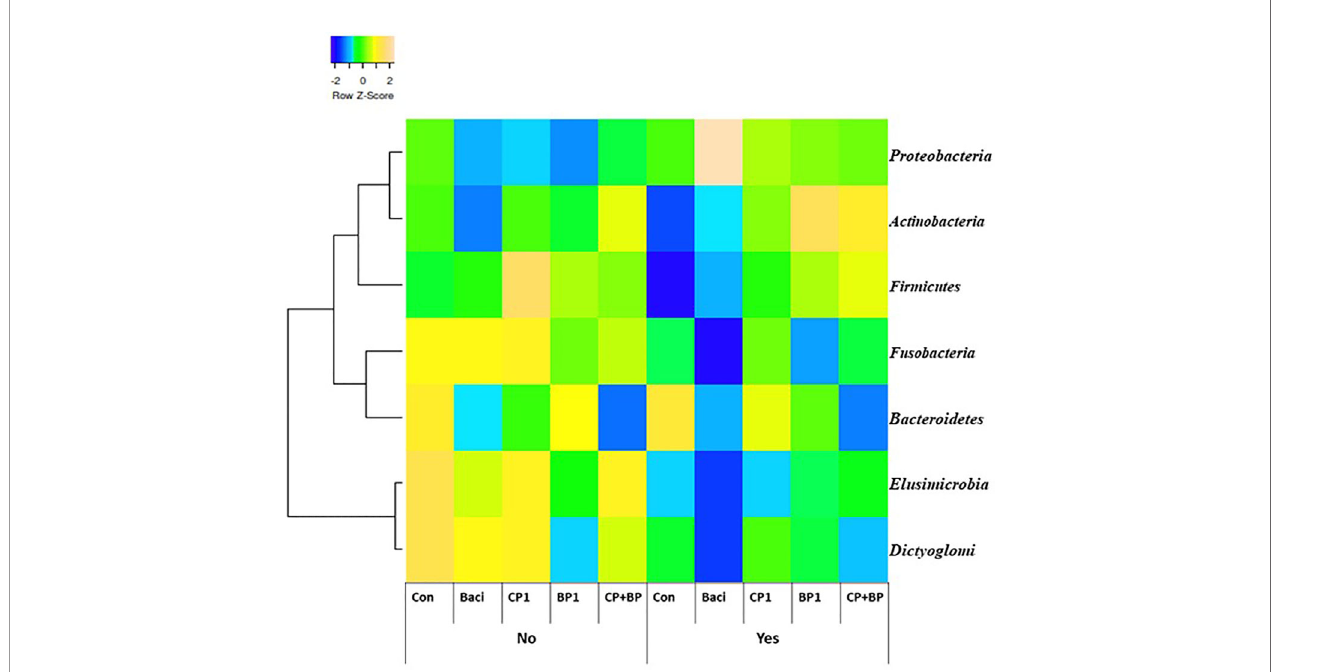
FIGURE 4 | Cecal bacterial taxa at the phylum level in broiler chicken fed bacitracin (55 ppm), 1% of each pomace of cranberry (CP1) and blueberry (BP1) alone or their combination (CP+BP). Birds were vaccinated not vaccinated against